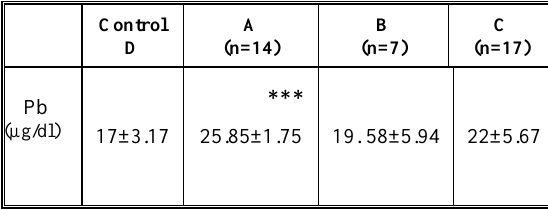
Table(2): The cutoff values of the studied parameters.